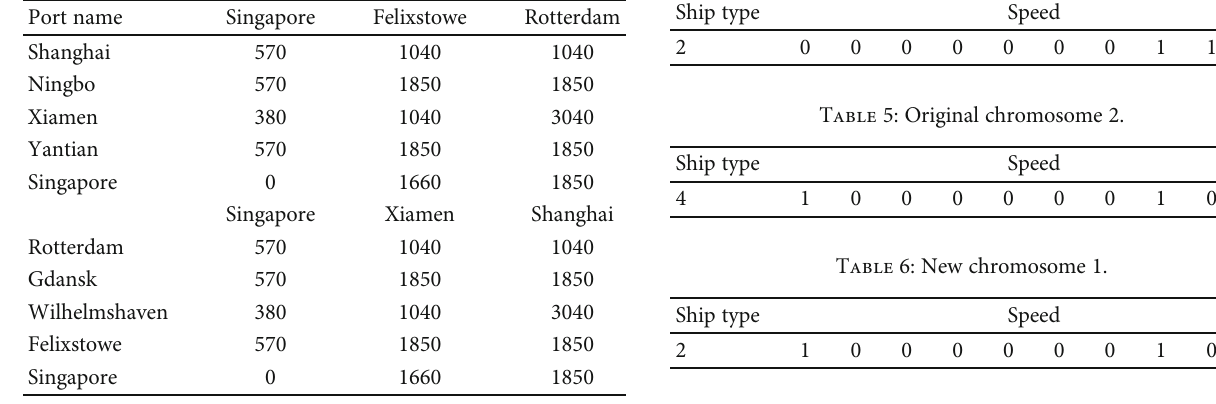
Table 7: New chromosome 2.